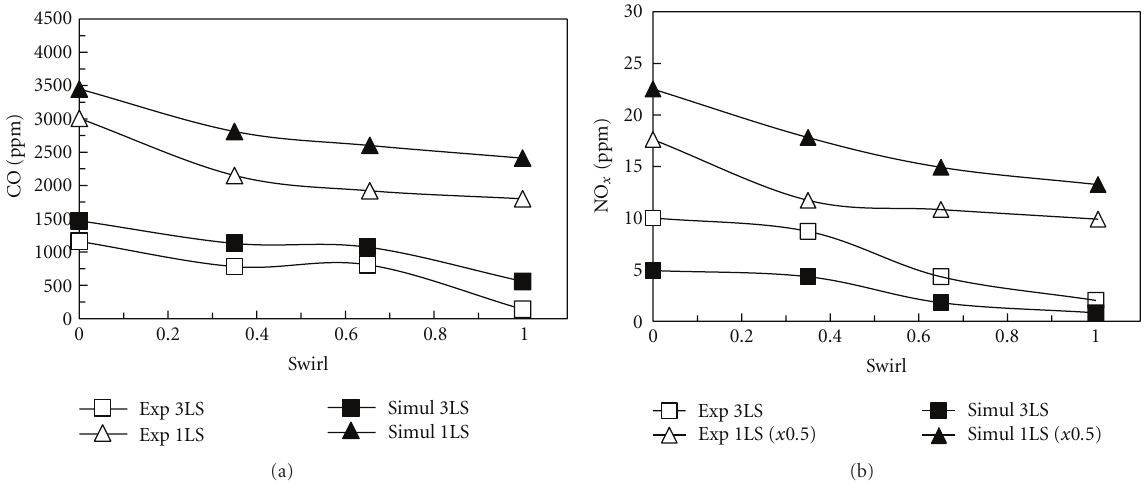
Figure 10: Experimental and computed major species global exhaust levels for the single- and the three-disk arrangements, (a) CO, and (b) NO x